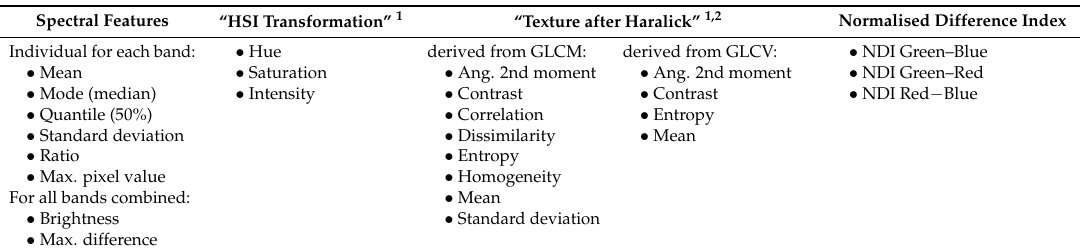
Table 4. Object features used in the Random Forest